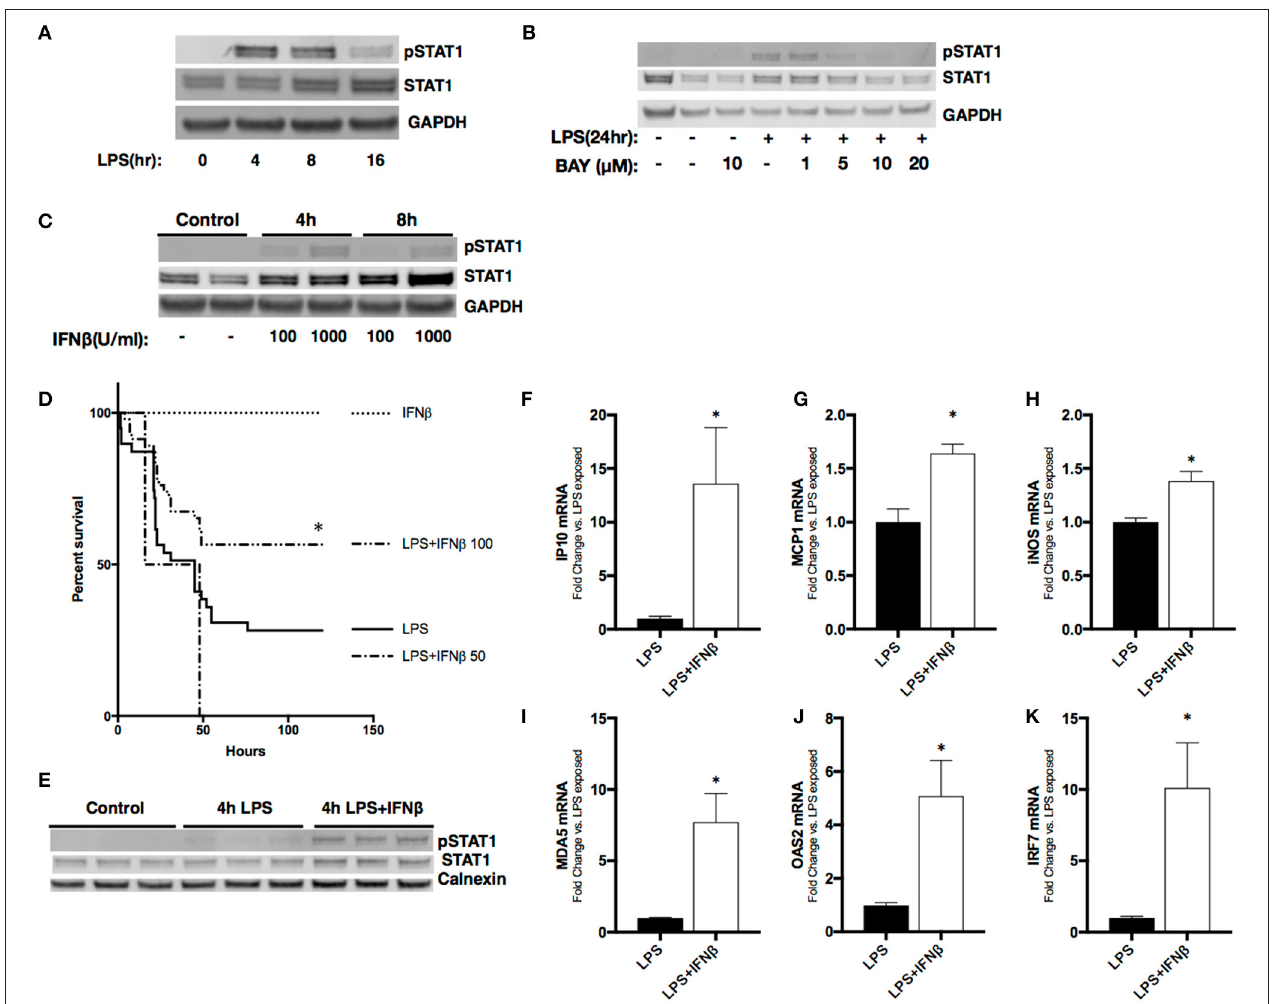
FIGURE 5 | Treatment with IFN β following LPS exposure reduces mortality and activates pulmonary STAT1 signaling in neonatal mice. (A) Representative Western Blot of phosphorylated and total STAT1 in RAW 264.7 macrophage lysate following LPS exposure (1 µ g/ml, 0–16h) with GAPDH shown as loading control. (B) Representative Western Blot of phosphorylated and total STAT1 in RAW 264.7 lysates following LPS exposure (1 µ g/ml, 0–24h) or BAY 11-7085 pretreatment (1–20 µ M, 1h) and LPS exposure with GAPDH shown as loading control. (C) Representative Western Blot of phosphorylated and total STAT1 in RAW 264.7 lysates following IFN β exposure (100–1,000 µ /ml, 0–8h) with GAPDH shown as loading control. (D) Kaplan-Meier curve analysis of neonatal mice exposed to IFN β (100 µ /g; n = 7), LPS (10 mg/kg; n = 39), or LPS and IFN β (50 ( n = 7) or 100 µ /g ( n = 46), administered 2h post-LPS. * p < 0.05 vs. LPS-exposed; n = 7–40 per group. (E) Representative Western Blot of phosphorylated and total STAT1 in neonatal pulmonary lysates following LPS exposure (5 mg/kg, 4h) or LPS exposure and IFN β exposure (100 µ /g, administered 2h post-LPS). n = 3/timepoint (F–K) Fold-increase in gene expression of STAT1 target genes IP10, MCP1, iNOS, OAS2, MDA5, and IRF7 in neonatal lung following LPS (5 mg/kg, 4h) or LPS exposure and IFN β exposure (100 µ /g, 2h post-LPS). Values shown as means of fold induction normalized to mean LPS-induced fold induction ± SEM. * p < 0.05 vs. LPS-exposed; n =